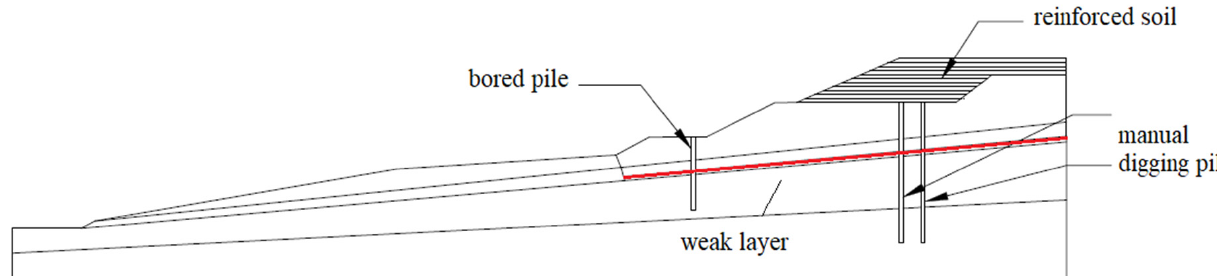
Figure 14. Final reinforcement scheme of slope.